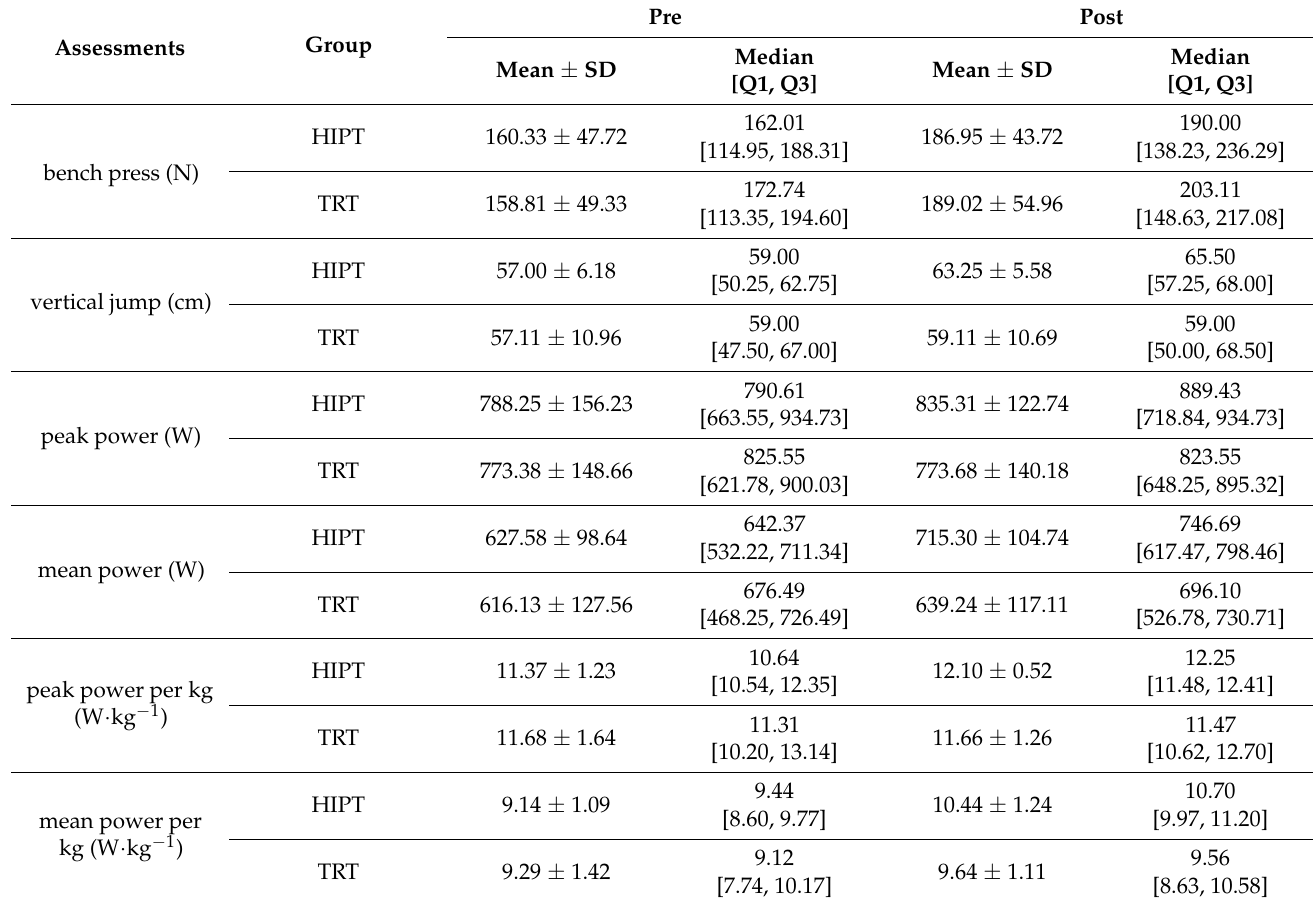
Table 2. Pretest and post-test of the HIPT and TRT